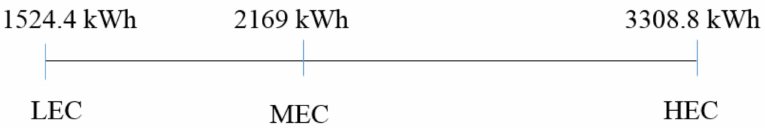
Figure 6. Quantitative distribution of energy usage